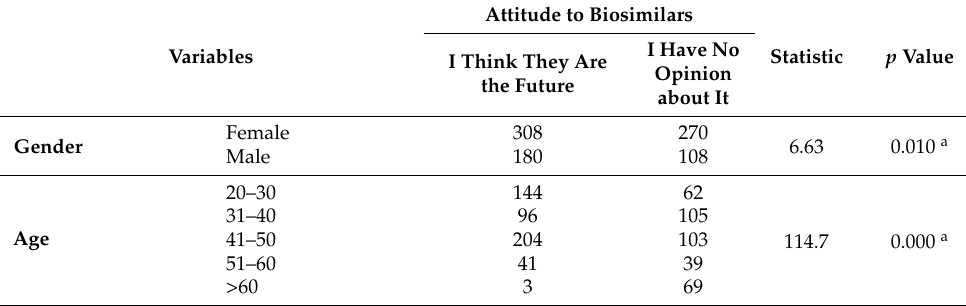
Table 3. Attitude to biosimilars vs. sociodemographic